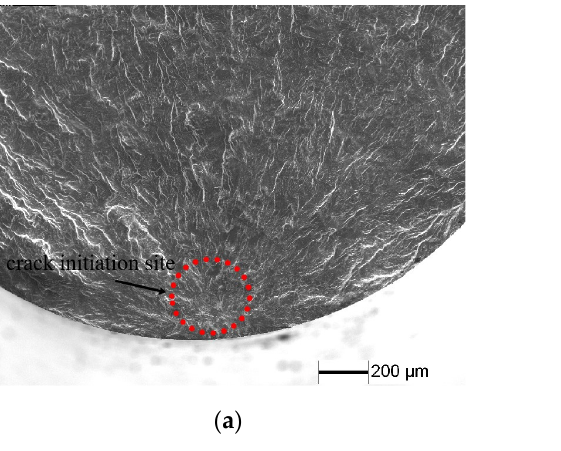
Figure 5. Fatigue fracture surface of TC21 titanium alloy at σ = 480 MPa, N = 8.76 × 10 6 ycles: ( a ) fatigue crack initiation site; and ( b ) high magnification morphology.